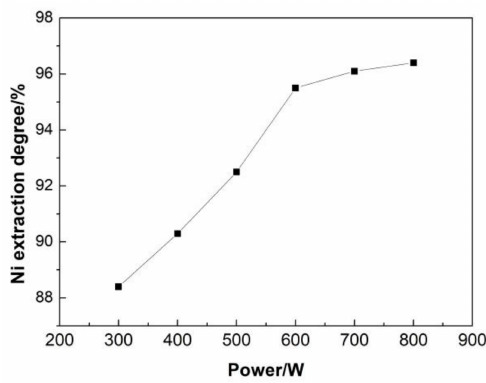
Figure 8. Influence of ultrasonic power on the Ni extraction degree. Leaching temperature = 25 ◦ C, mass fraction of sulfuric acid = 15%, particle size = − 150 µ m, solid-liquid ratio = 1:7, leaching time = 40 min.